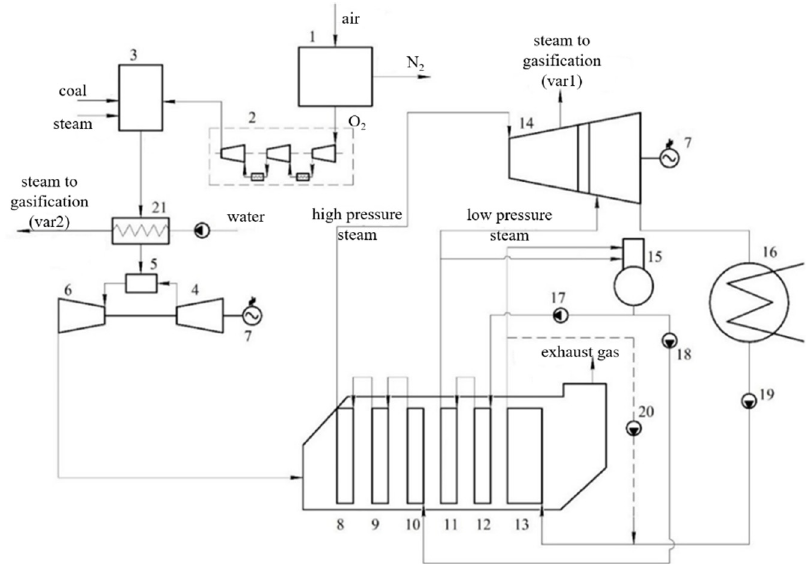
Figure 1. Heat flow scheme of a CC facility with the steam–oxygen coal gasification. 1—air split unit; 2—oxygen compressor with inter-cooling; 3—gasification block; 4—air compressor for gas turbine cooling; 5—gas turbine combustor; 6—gas turbine; 7—electric power generator; 8, 11—high and